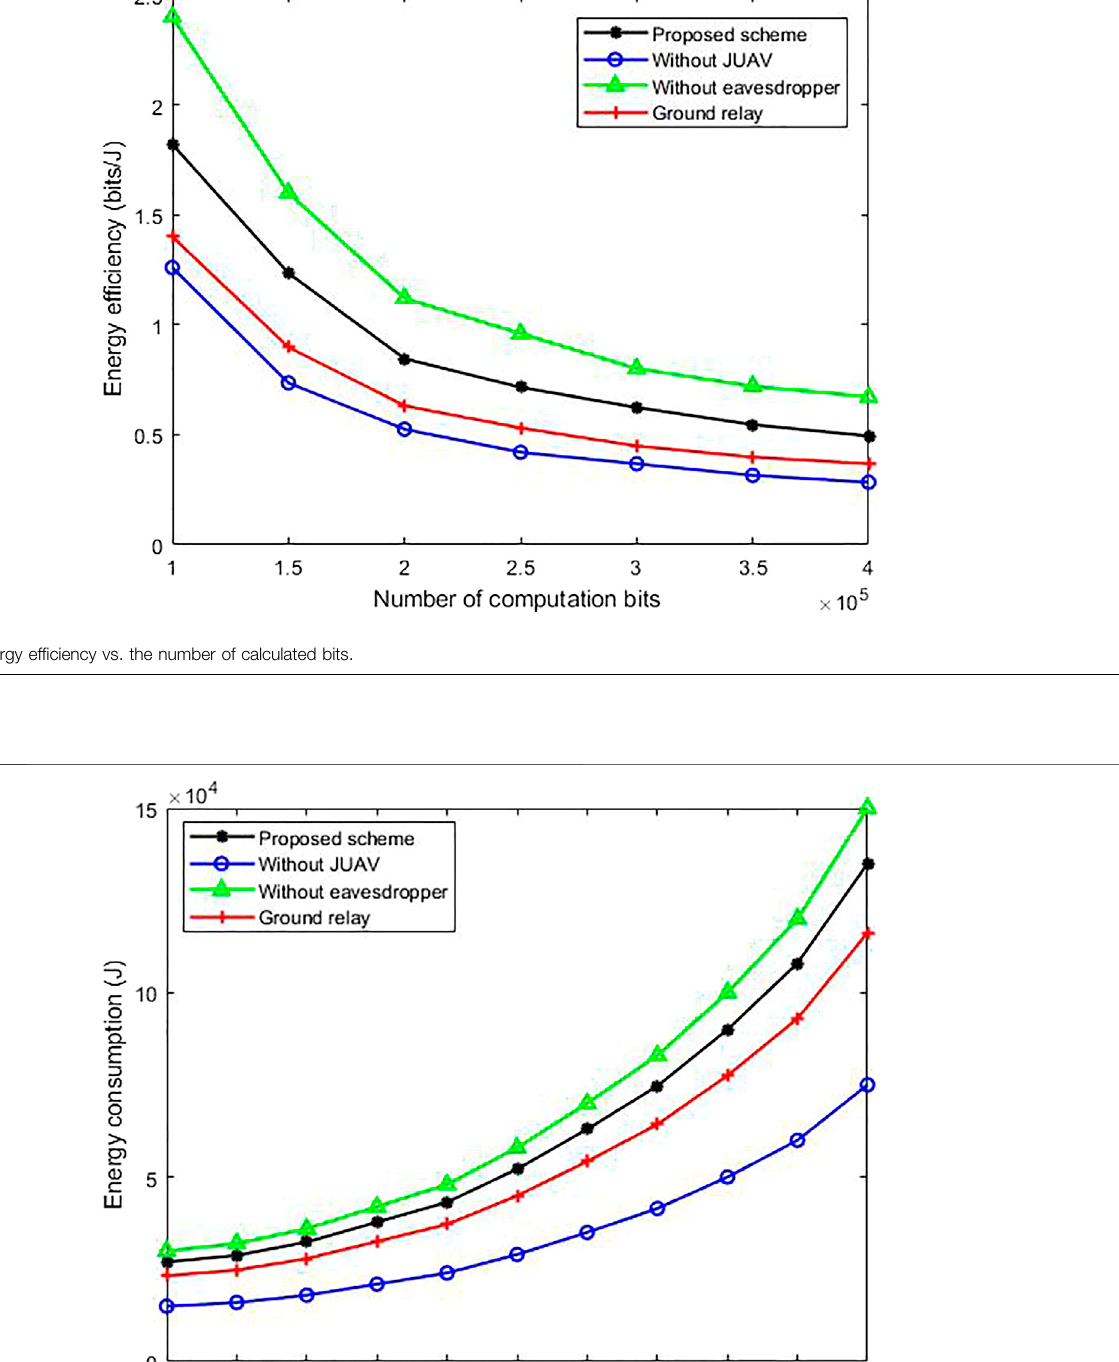
Frontiers in Computer Science |